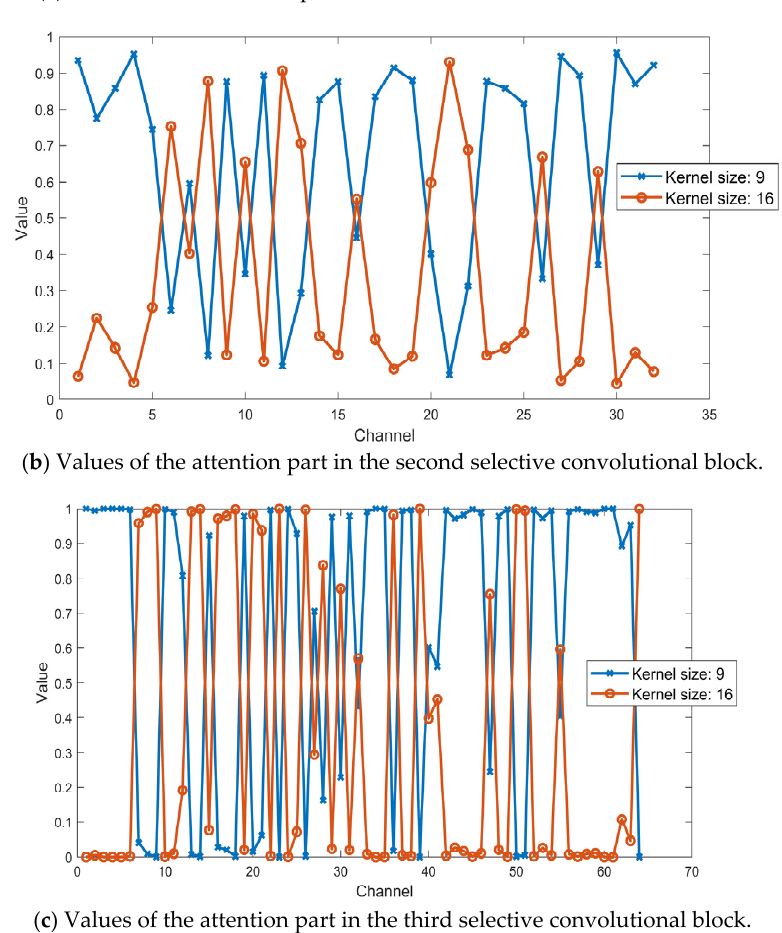
Figure 8. Values of the attention part in the first, the second and the third selective convolutional block with the same SFM